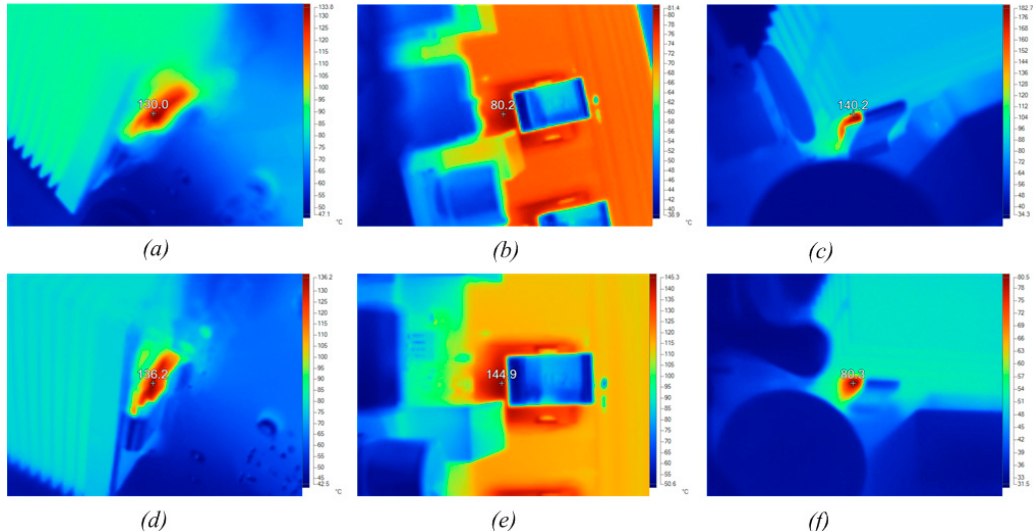
Figure 11. Thermal images in the nominal operation mode: QZS-stage diode ( a ) and SiC bridge power switches ( b ) in the 2L QZSI and QZS-stage diode in the 3L NPC QZSI ( c ); thermal images in the boost mode under ST states application: QZS-stage diode ( d ) and SiC bridge power switches ( e ) in the 2L QZSI and QZS-stage diode in the 3L NPC QZSI ( f ).